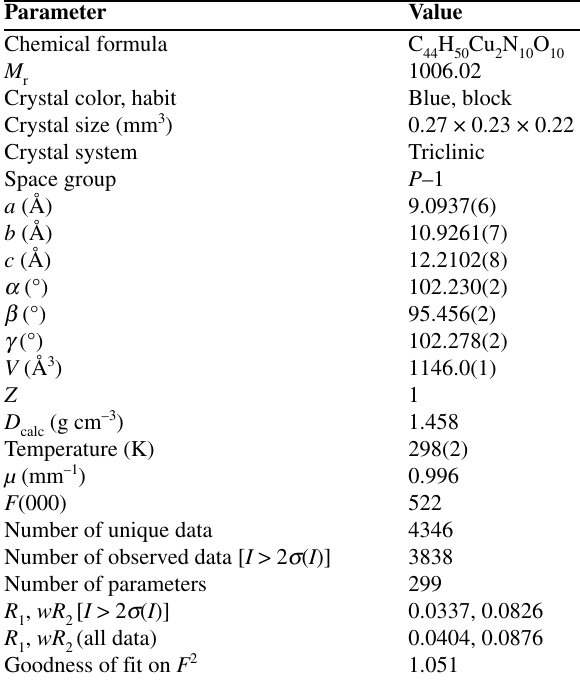
Table 1 . Crystallographic data and refinement parameters for the complex